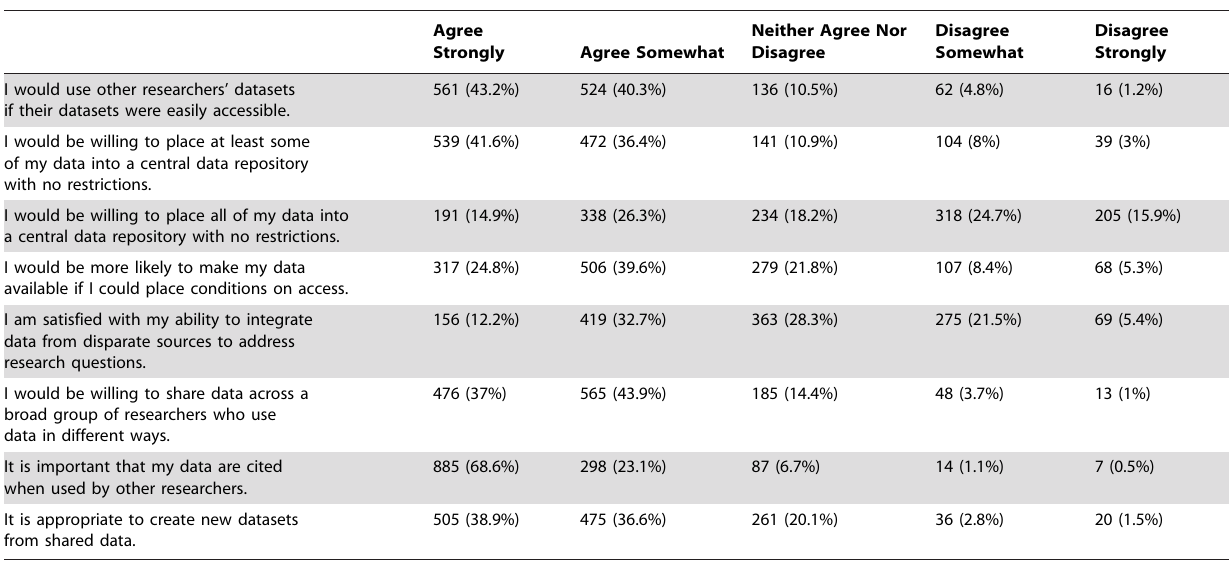
Table 13. Conditions for data sharing.